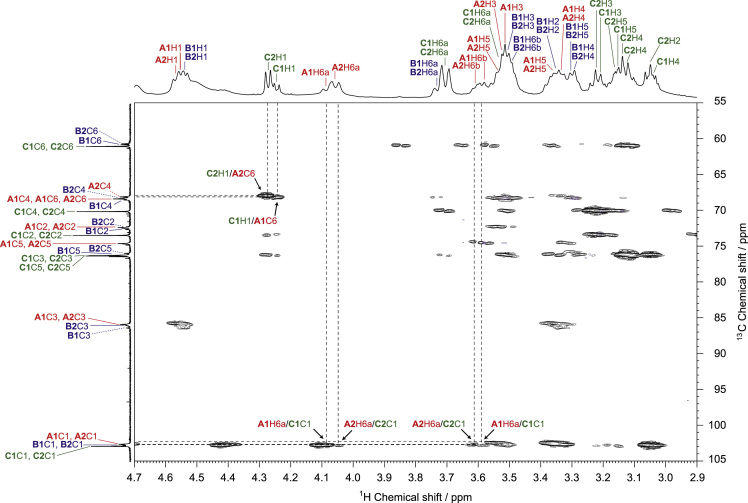
HMBC spectrum of the water-soluble β-(1→3, 1→6)-glucan from A. pullulans in DMSO-d6 at 363 K. The arrows indicate the inter-residual correlations between C1C1–A1H6a, C1C1–A1H6b, C2C1–A2H6a, C2C1–A2H6b, C1H1–A1C6, and C2H1–A2C6 via glycosidic bonds.